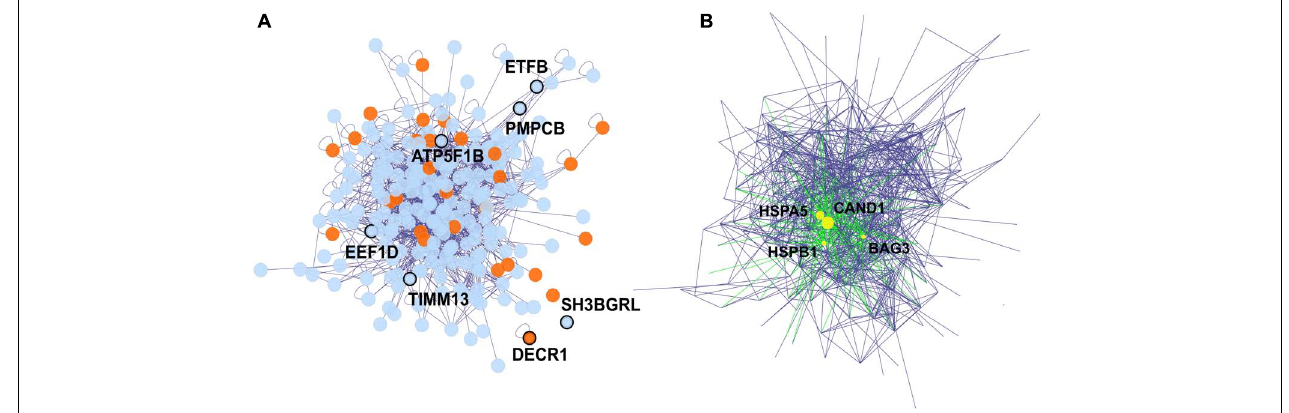
FIGURE 5 | The protein-protein interaction network of proteins detected in both in vitro and biopsies datasets, and that were weighted proteins in at least one dataset. Edges represent the protein-protein interaction, and nodes represent proteins, 16 orphan nodes were removed from the network. (A) The 7 nodes with protein names in bold and showing thicker border were weighted protein in both in vitro and biopsies dataset. Proteins associated with heart failure (detected via DisGeNET), were highlighted in orange. (B) The 4 hub proteins ( > 30 degrees of connection) of the protein-protein interaction network are shown as yellow